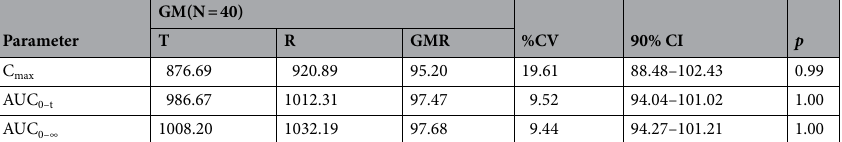
Table 2. Bioequivalence analysis of main pharmacokinetic parameters of subjects after single oral administration of test preparation T and reference preparation R. C max maximum blood concentration, AUC 0–t Area under curve from time 0 (baseline) to time t; AUC 0–∞ Area under curve from zero to infinity, GM = geometric mean, GMR = geometric mean ratio, GMR values report the geometric mean ratio and 90% confidence interval. p > 0.05, not